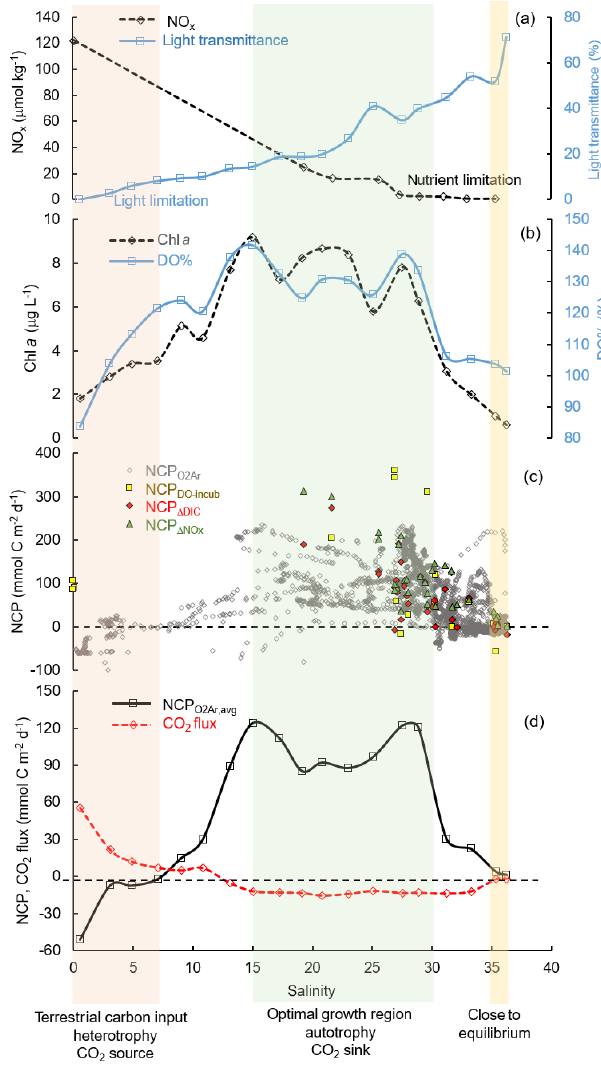
Figure 7. The distribution of (a) NO x and light transmittance, (b) Chl a and DO%, (c) NCP estimated from various methods, and (d) NCP O and CO 2 flux along the salinity gradient in the Missis- 2 Ar sippi plume. Data in (a) , (b) , and (d) were averaged over increments of 2 salinity units.